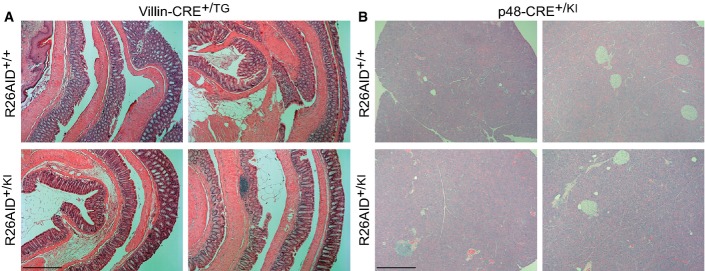
Heterologous AID expression does not promote carcinoma developmentRepresentative H/E stainings in colonic tissue from 75-week-old R26AID+/+VillinCRE+/TG (top) and R26AID+/KIVillinCRE+/TG (bottom) mice. Scale bar: 500 μm.
Representative H/E stainings in pancreatic tissue from 75-week-old R26AID+/+p48CRE+/KI (top) and R26AID+/KIp48CRE+/KI (bottom) mice. Scale bar: 500 μm.